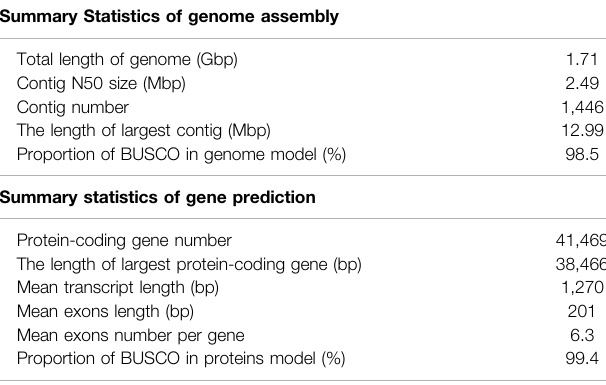
TABLE 1 | Summary statistics of genome assembly and gene prediction of P. esculenta